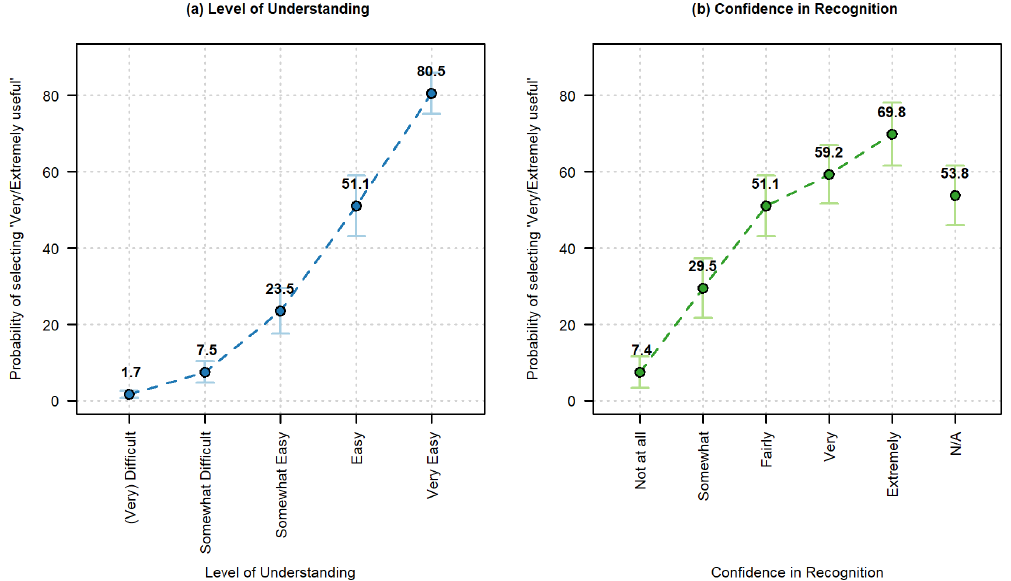
Figure 3. Estimated marginal probabilities for selecting very useful or extremely useful for usability of the statement as a function of (a) participants’ level of understanding and (b) their confidence in recognizing the condition or feature. Error bars represent 95% confi- dence intervals for probabilities calculated from the subsample for the particular parameter level. Variable levels for calculations of estimated marginal probabilities: avalanche awareness level – introductory, attention to TTA statements – considerable, years of backcountry experi- ence – 6–10 years, average number of days in the backcountry per winter – 11–20d, level of understanding – easy ( b only), and confidence in recognition – fairly confident ( a